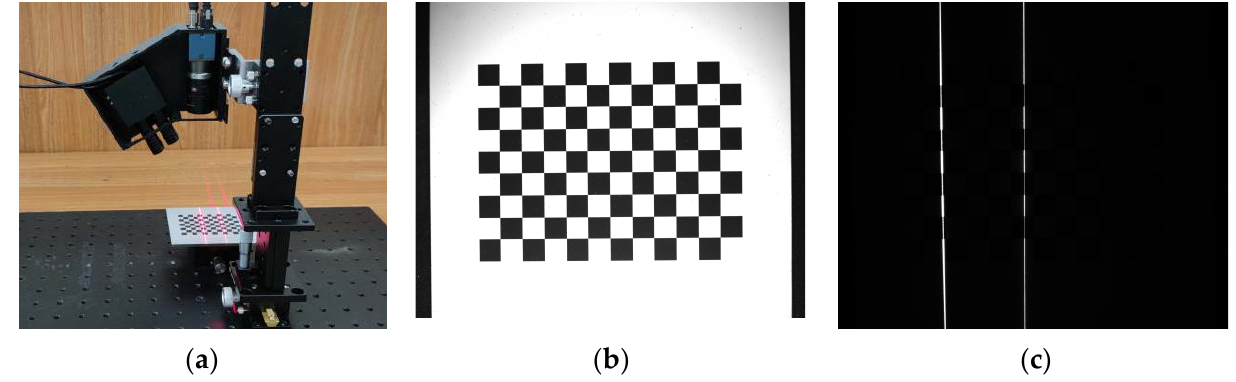
Figure 3. Image acquisition process of vision sensor calibration: ( a ) image acquisition, ( b ) captured image of checkerboard calibration board and ( c ) captured image of two laser projection lines.